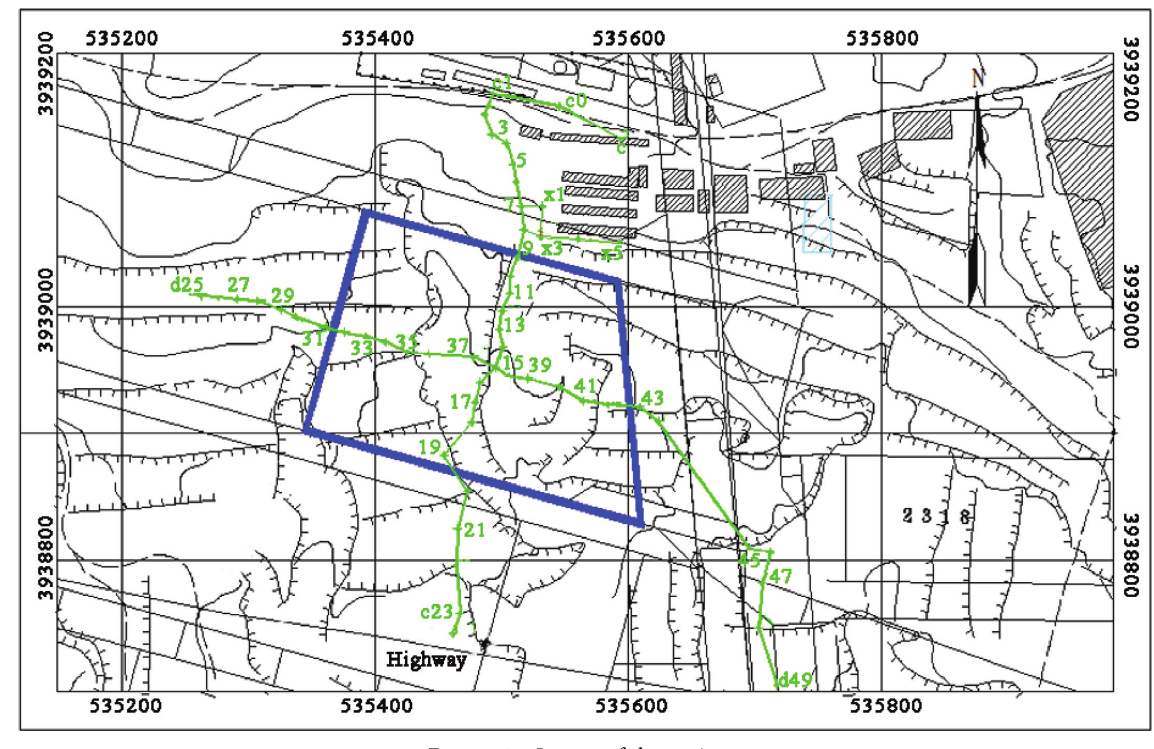
Figure 15: Layout of the